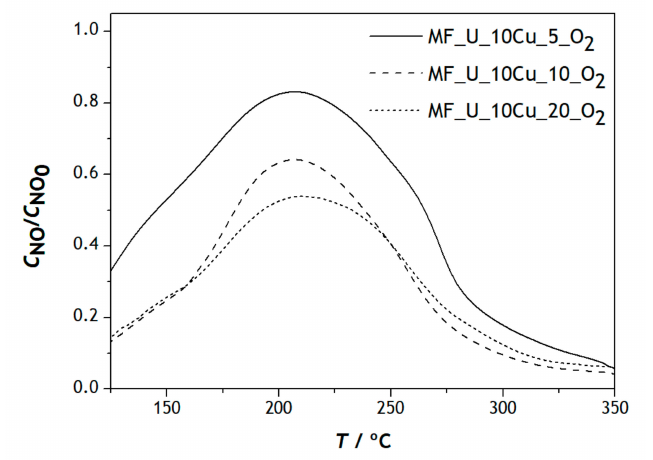
Figure A3. NO and NO 2 concentrations in the presence of CX and CX_N with and without metals with [NO] = 1000 ppm in He with 5% of O 2 .